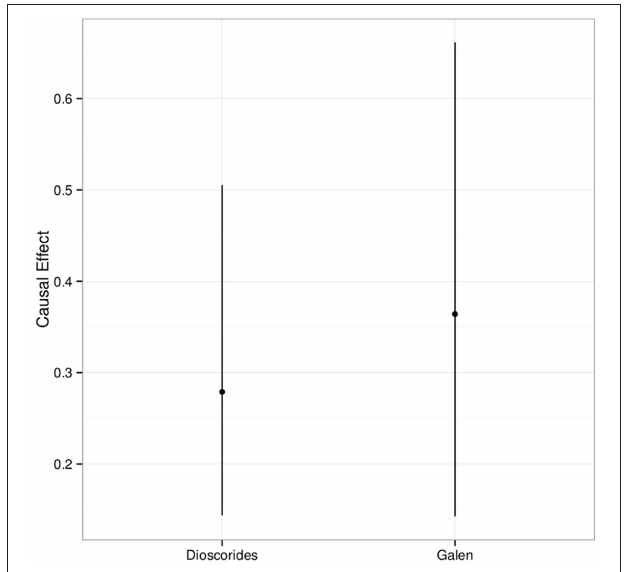
FIGURE 5 | Overall posterior distribution of the causal effect of Dioscorides and Galen on the contemporary plant use traits over all 87 taxa, 11 uses-categories and for all three regions together. The plot shows the mean effect (point) along with the 95% credible